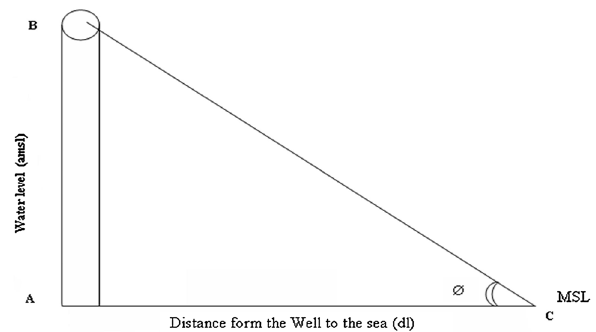
Fig. 10 Inclination of the water level to the mean sea level